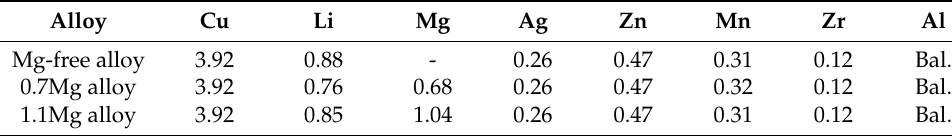
Table 1. Chemical composition of investigated alloys (all in wt.%).